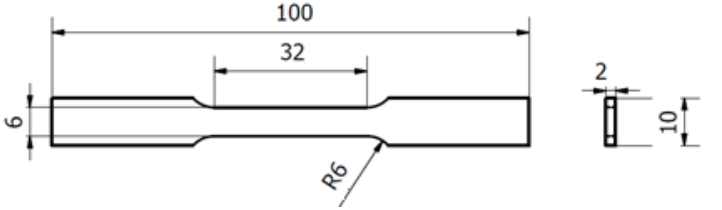
Figure 2. Tensile test specimen measurements, in mm (ISO 6892).